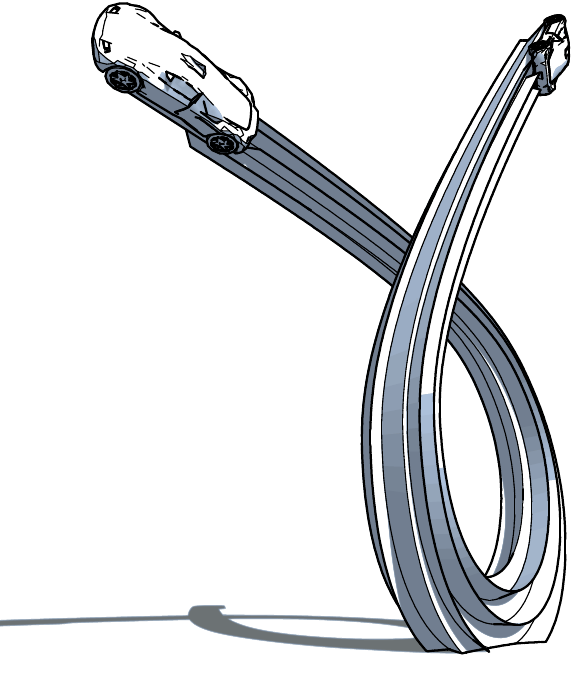
Figure 31. Homography sculpture, 3D view.